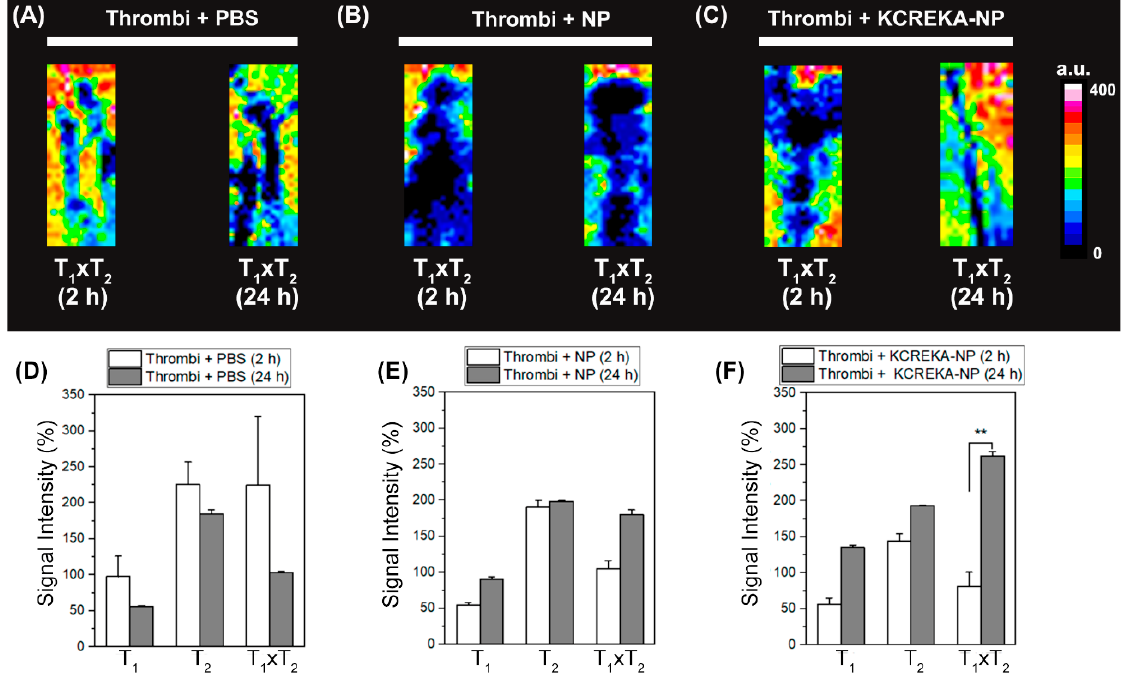
Figure 7. Representative MR T 1 × T 2 reconstruction of the thrombus (2 h vs. 24 h incubation time) introduced through the right external carotid artery up to the intracranial internal carotid artery bifurcation to occlude the MCA rat brain. Clots were immersed in ( A ) PBS, ( B ) NP, or ( C ) KCREKA- NP solutions before MCA occlusion in order to assess the signal variation due to the age of the thrombus. Thrombus signal intensity changes (T 1 -wi, T 2 -wi, and T 1 × T 2 ) are plotted over incubation time for the three immersed solutions—( D ) PBS, ( E ) NP, and ( F ) KCREKA-NP. ** p < 0.01, using one way ANOVA followed by Kruskal-Wallis test.